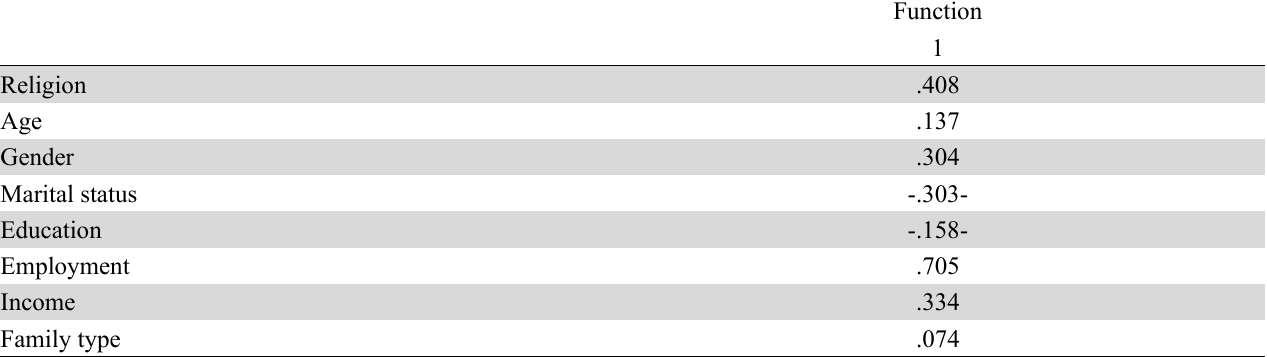
Standardized Canonical Discriminant Function